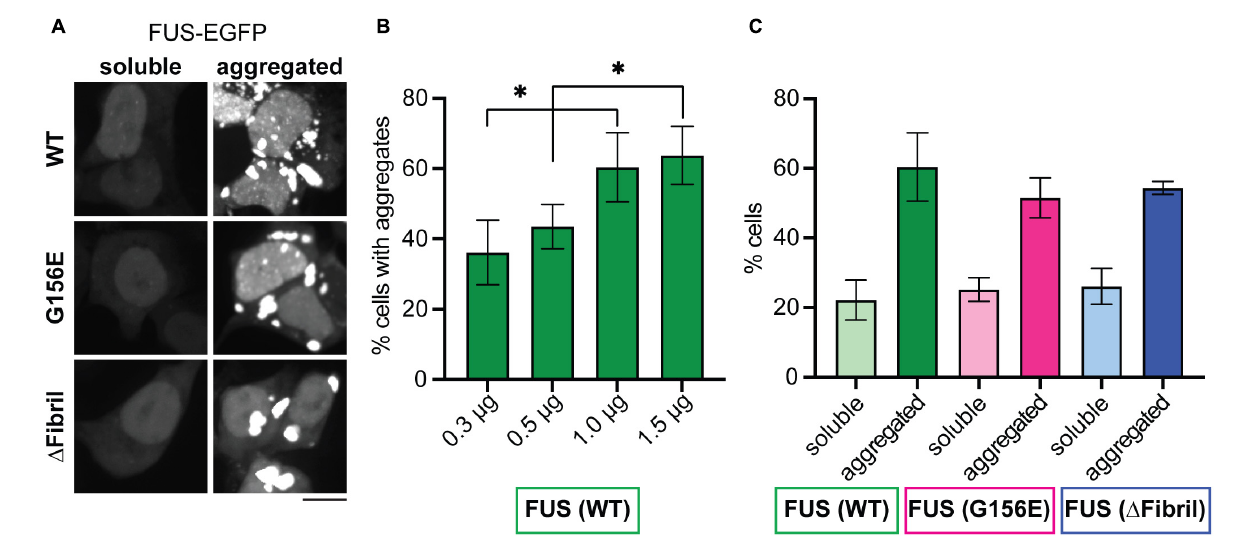
FIGURE 4 | Increasing concentration of cytosolic FUS leads to aggregation for both wild-type and mutated proteins. (A) Representative images (z-projections) of HEK cells expressing full-length FUS-EGFP (wild-type, top; G156E middle, (cid:49) Fibril, bottom) show both diffuse signal and aggregates. Scale bar, 10 µ m. (B) The percentage of cells that contain aggregates of FUS with the increased amounts of transfected FUS-EGFP construct. (C) The percentage of cells that contain either soluble or aggregated wild-type FUS (green), FUS G156E (magenta), and FUS (cid:49) Fibril (blue) upon transfection with 1 µ g of the corresponding construct. Bars represent average values with standard deviation; ∗ P < 0.05, two-sided, unpaired t -test; each experiment is done in three different rounds of transfections with at least two hundred analyzed cells for each